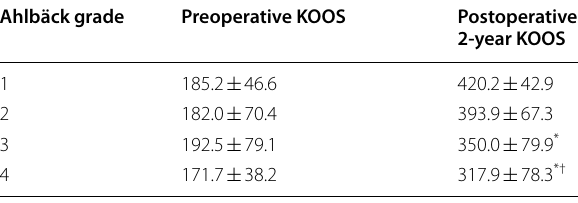
Significant differences in postoperative 2-year KOOS between Ahlbäck grade 1 and grade 3, 4 (* P < 0.01) and between Ahlbäck grade 2 and grade 4 ( † P < 0.01) by one-way ANOVA Post-hoc Tukey’s test